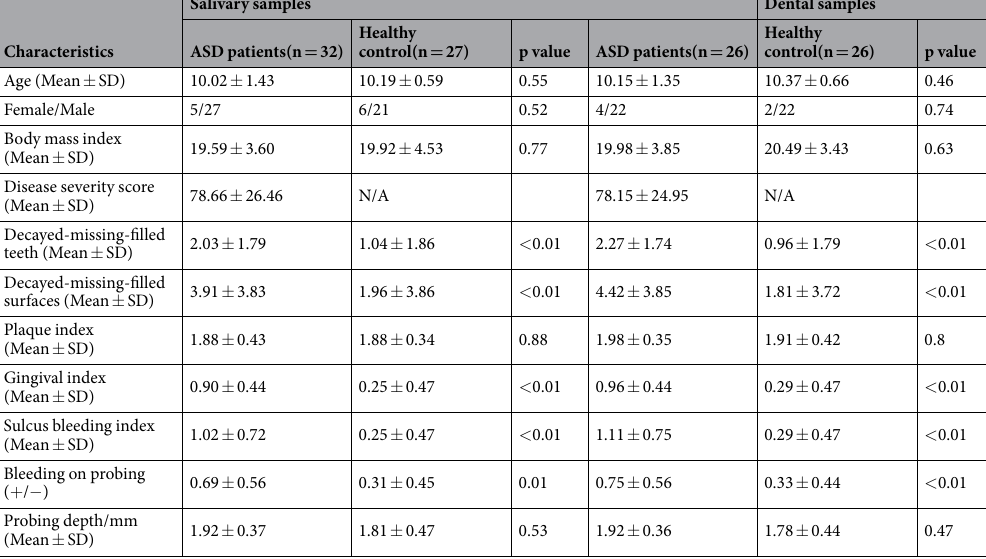
Table 1. Demographics and clinical parameters of the